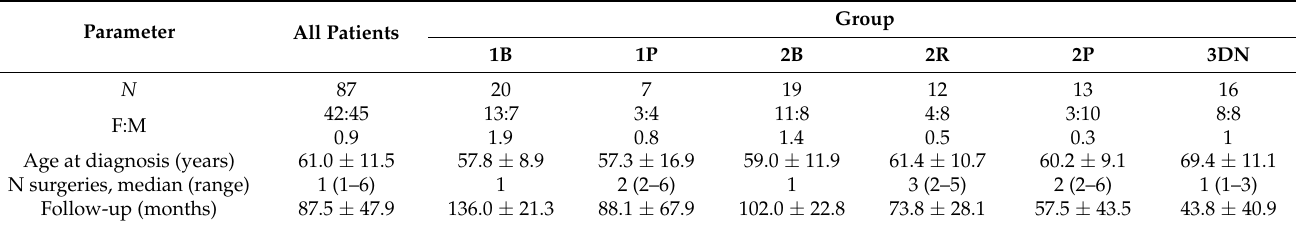
Table 1. Clinical characteristics of meningioma